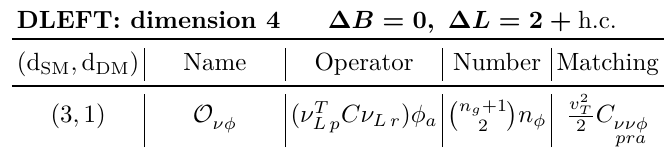
Table 29 . Dimension-four ∆ B = 0 , ∆ L = 2 operator in DLEFT. The first column gives the dimensions of the SM and DM part of the operator, the fourth column is the number of operators, and the fifth column is the additional matching contribution at the EW